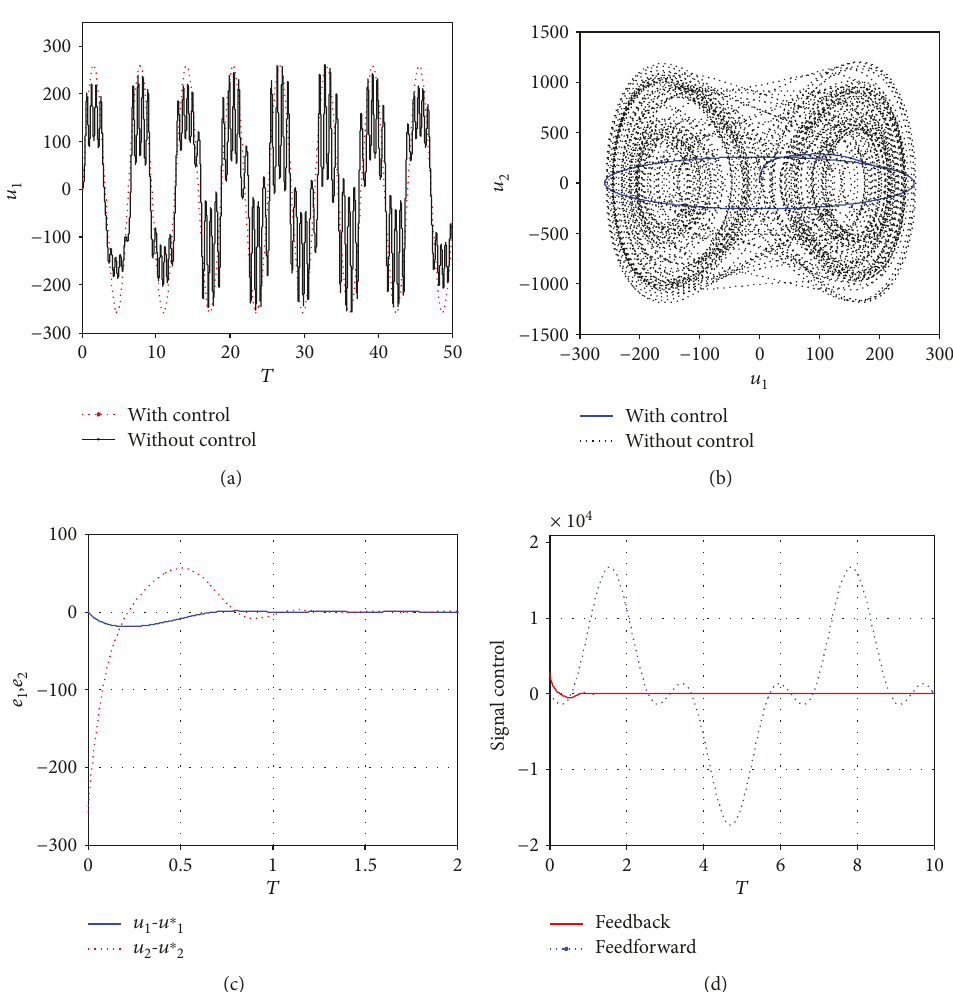
Figure 7: MEM system with proposed control. (a) Time history of state u